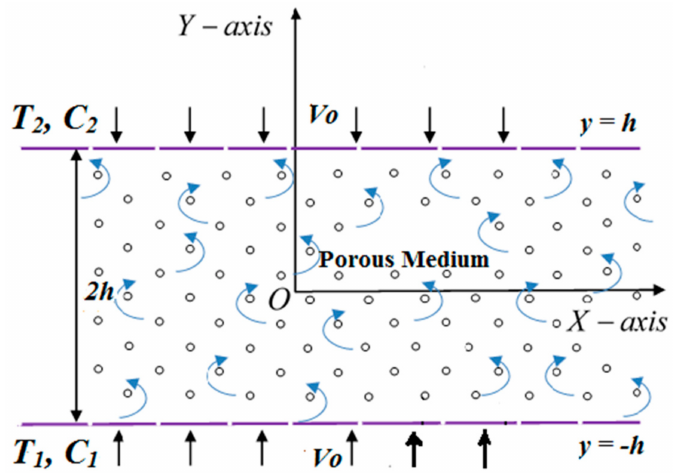
Figure 1. Geometry of the channel